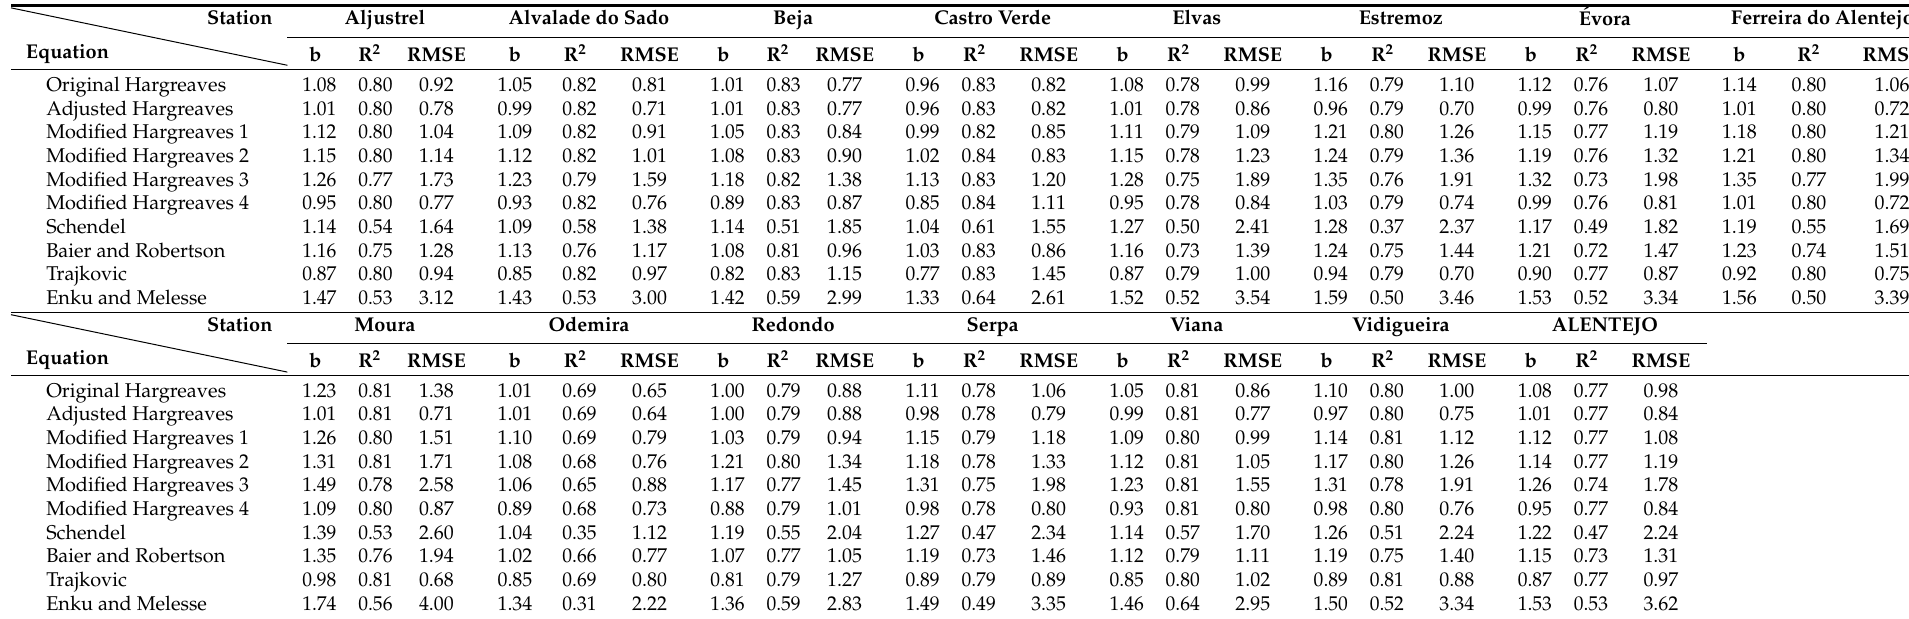
Table 5. Slope (b), coefficient of determination (R 2 ), and root mean square error (RMSE) for the relationship between daily ETo estimated by the Penman–Monteith equation and by nine temperature-based